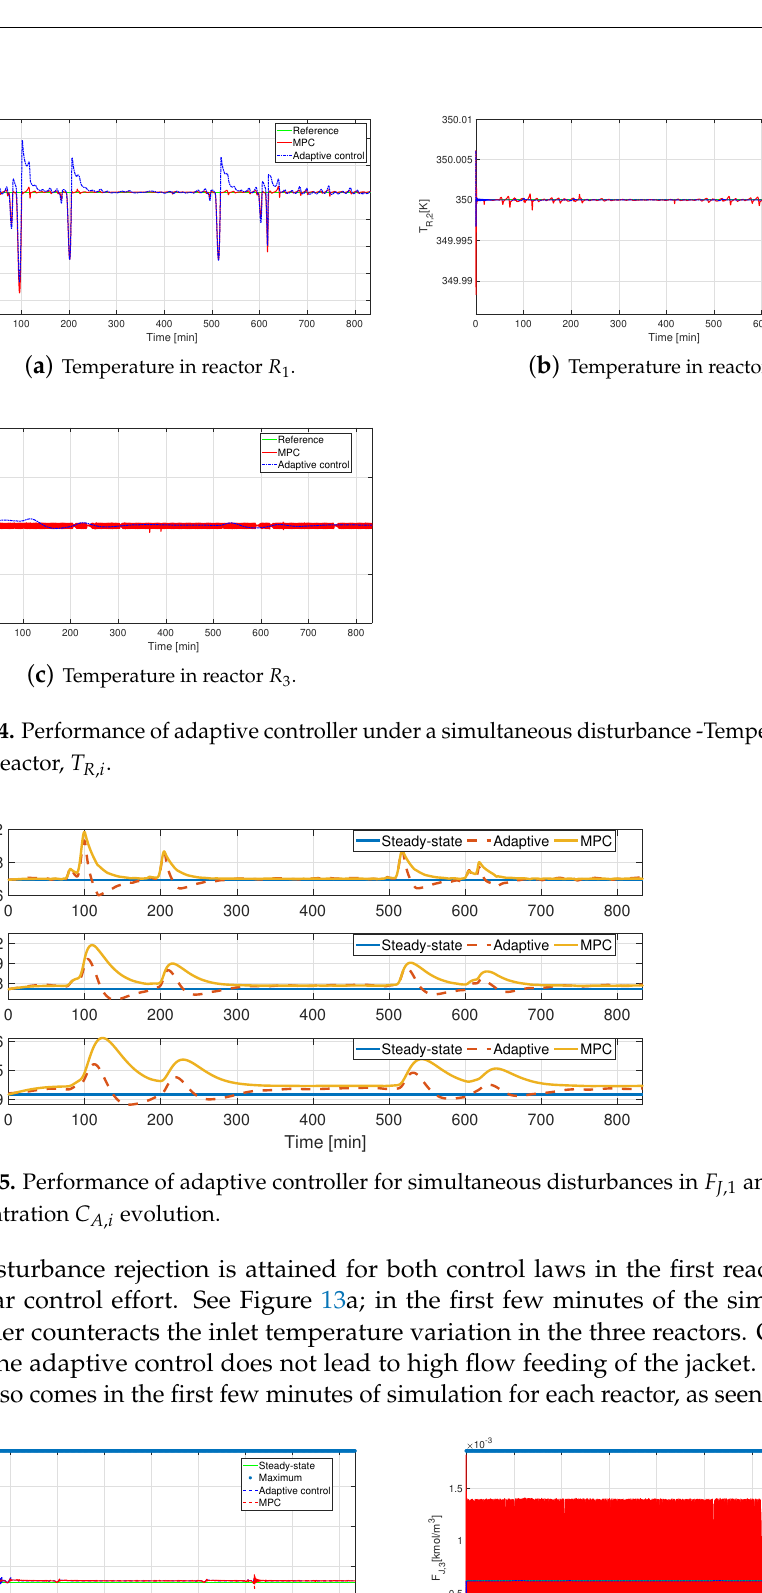
Figure 16. Performance of adaptive controller under a simultaneous disturbance—Jacket flow of R 2 and R 3